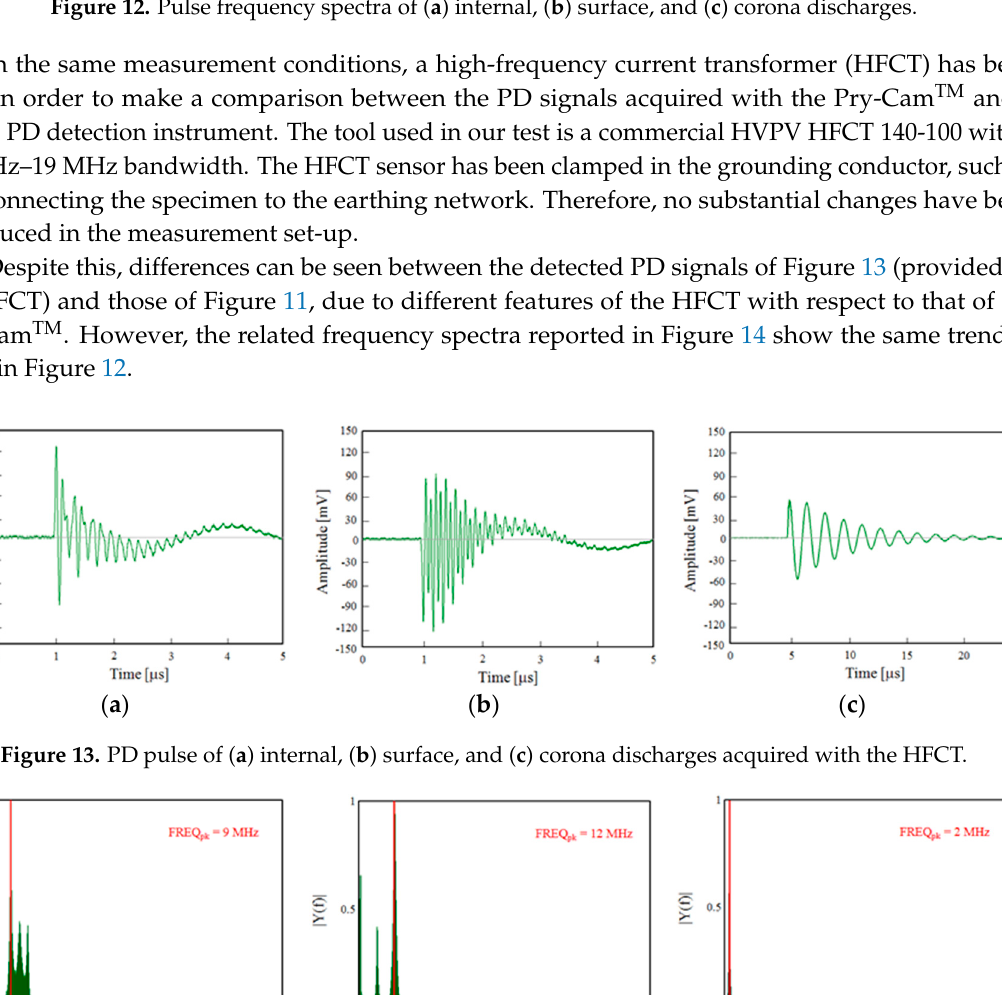
Figure 12. Pulse frequency spectra of ( a ) internal, ( b ) surface, and ( c ) corona discharges.